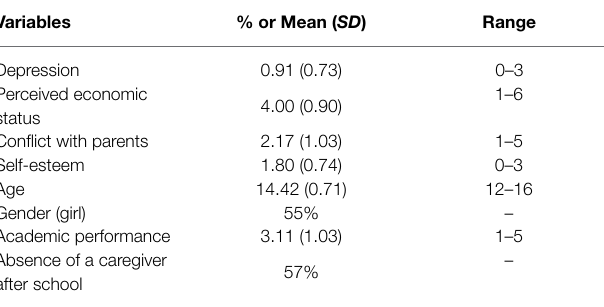
TABLE 1 | Sociodemographic and psychosocial characteristics of